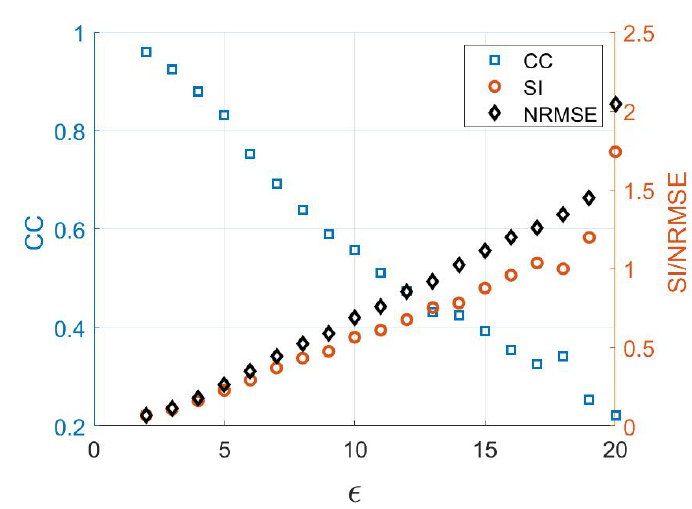
Figure 20. CC, SI and NRMSE of the estimated magnetic field for 1st